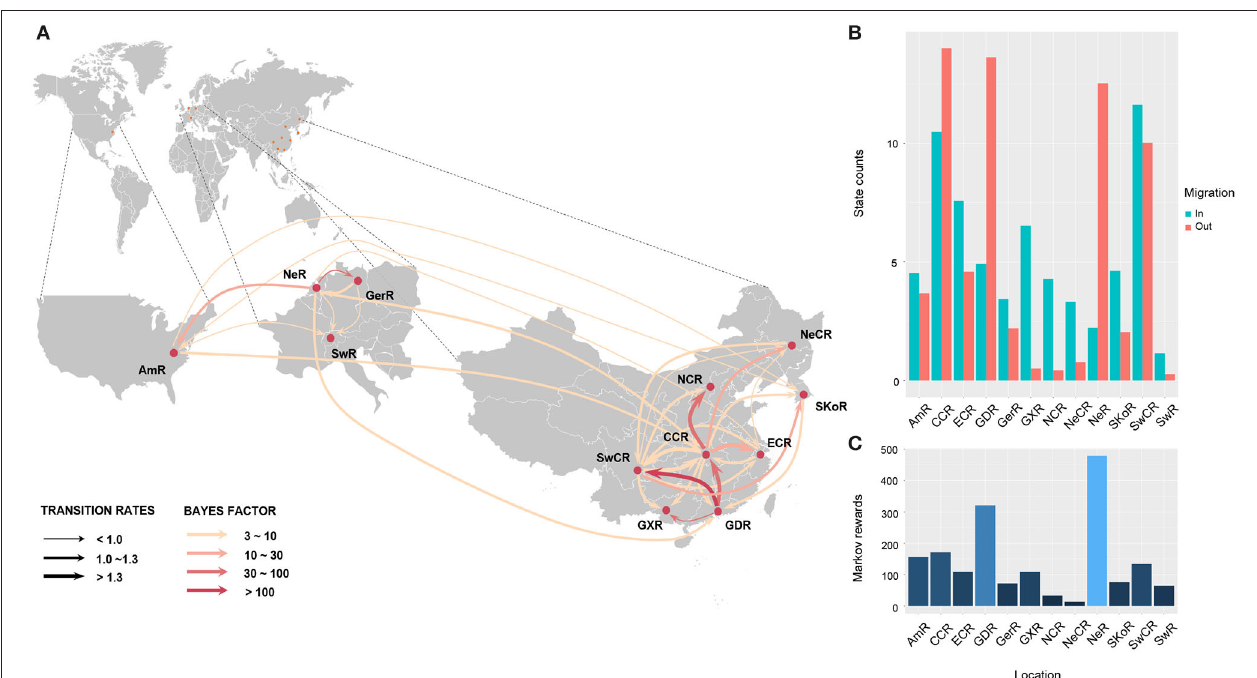
FIGURE 3 | Spatial migration of atypical porcine pestivirus. Supported migration pathways with different transition rates (A) , and both histograms of the total number of state counts for the migrations (B) and the time of transitions spent in each region (C) inferred from the E2 gene dataset. Gradual solid arrows, respectively, indicate decisively supported diffusions (BF > 100), very strongly supported diffusions (30 < BF < 100), strongly supported diffusions (10 < BF < 30), and supported diffusions (3 < BF < 10). SKoR, South Korea Region; GerR, Germany Region; SwR, Switzerland Region; NeR, Netherlands Region; AmR, USA Region; SwCR, Southwest China Region; NeCR, Northeast China Region; NCR, North China Region; ECR, East China Region; CCR, Central China Region; GXR, Guangxi Region; GDR, Guangdong